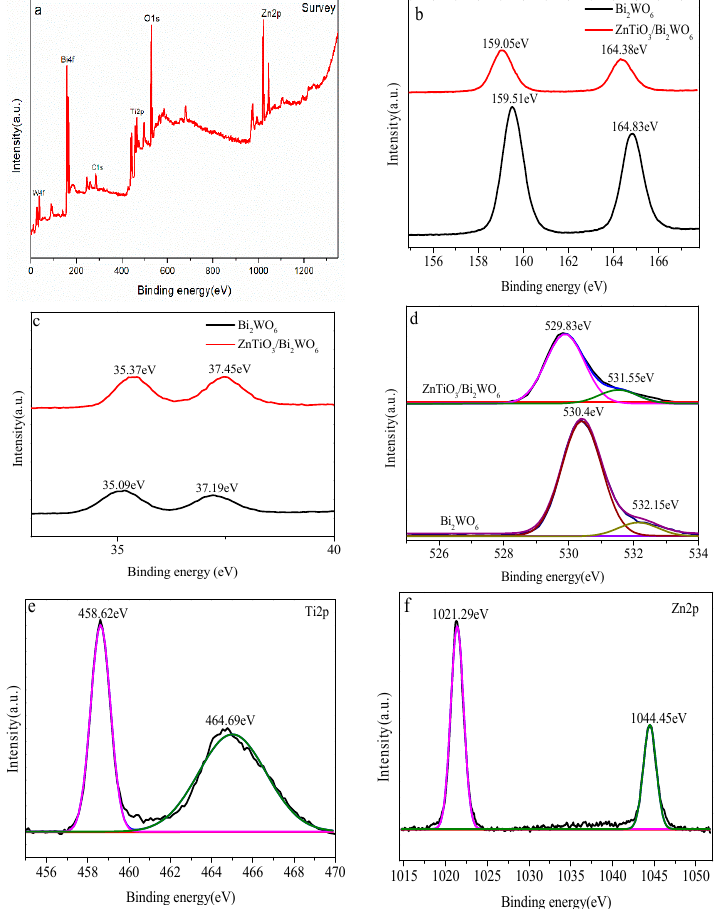
Figure 4. XPS spectra of pure Bi 2 WO 6 and ZnTiO 3 /Bi 2 WO 6 heterojunction: ( a ) survey spectrum; ( b ) Bi 4f element spectrum; ( c ) W 4f element spectrum; ( d ) O 1s element spectrum; ( e ) Ti 2p element spectrum; ( f ) Zn 2p element spectrum.